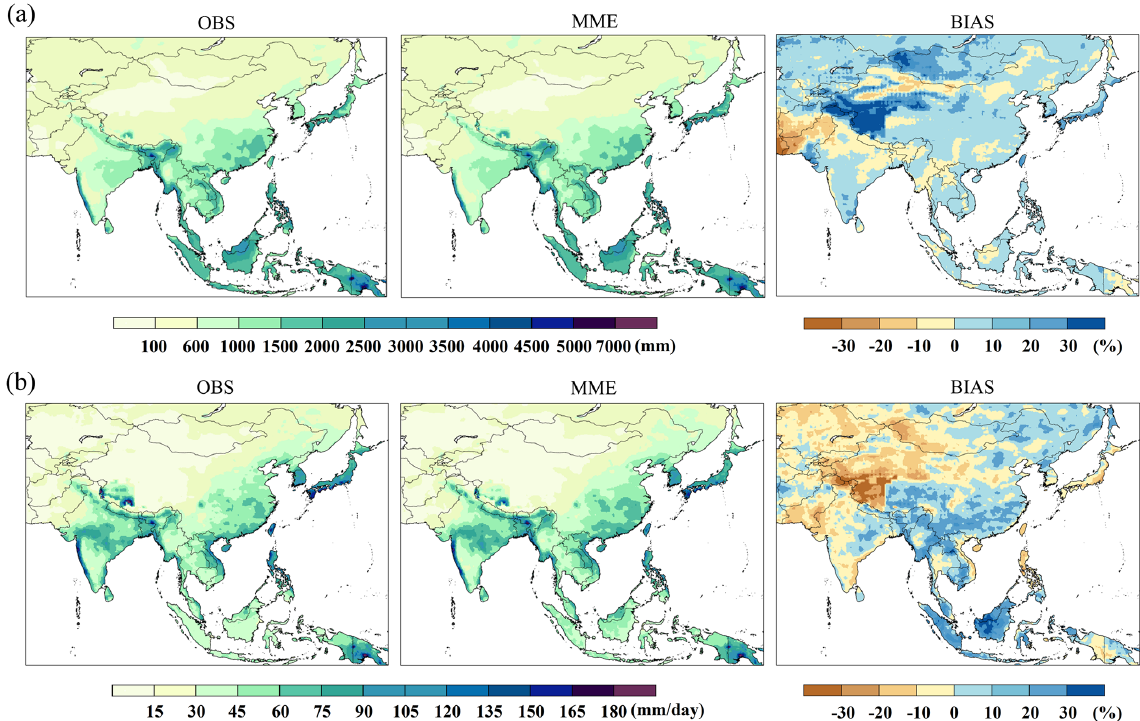
Figure 3. Spatial distributions of the (a) annual mean precipitation (PANN) and (b) annual maximum precipitation (PX1D) for the historical period (1976–2005) in the Asian monsoon region derived from observations (OBS) and the MME of bias-corrected outputs from the five GCMs. BIAS (i.e., the third column in each row) represents the percentage bias in PANN (PX1D) between OBS and